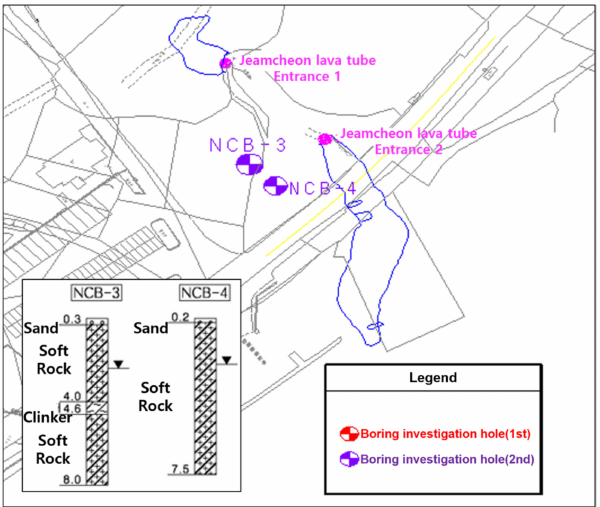
Figure 3. Cross sectional of boring investigation.